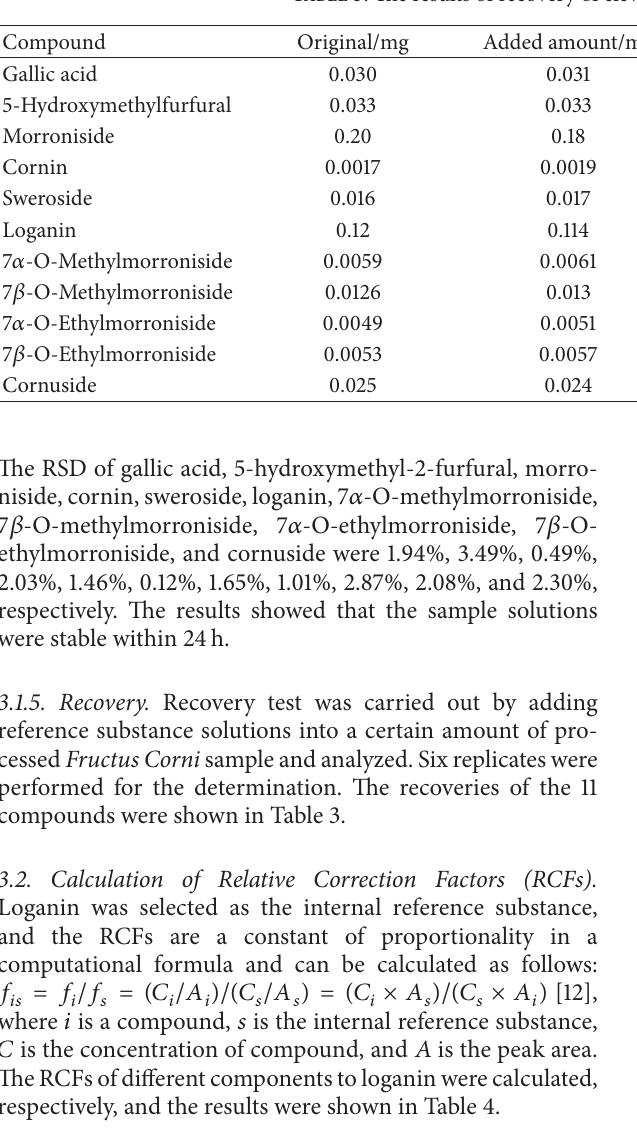
Table 3: The results of recovery of eleven components in samples ( 𝑛 = 6